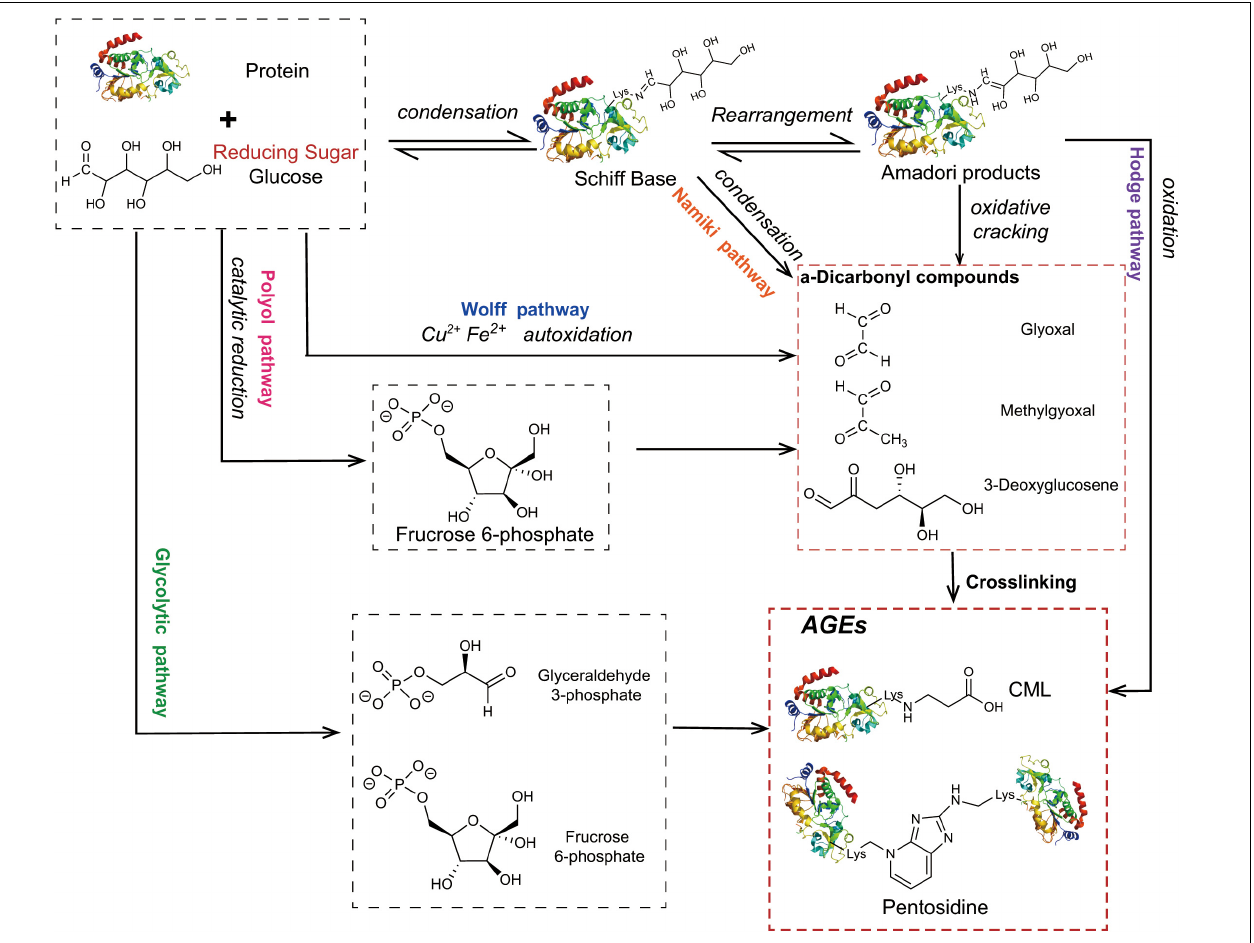
FIGURE 1 | The main pathway for the formation of AGEs. The condensation of the carbonyl group of the reducing sugar with the amino acid carbonyl amine forms a Schiff base, which is rearranged by an Amadori reaction to form a stable Amadori product. Some Amadori products are converted to AGEs by the Hodge pathway, and others are oxidized and cleaved to active dicarbonyl compounds. Active dicarbonyl compounds are further cross-linked with proteins to generate AGEs. These carbonyl intermediates are also generated by the Wolff pathway, Namiki pathway, and Polyol